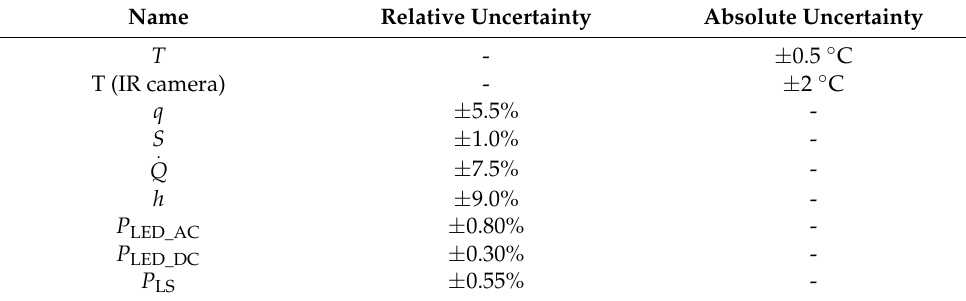
Table 1. Typical uncertainty of the measured values.